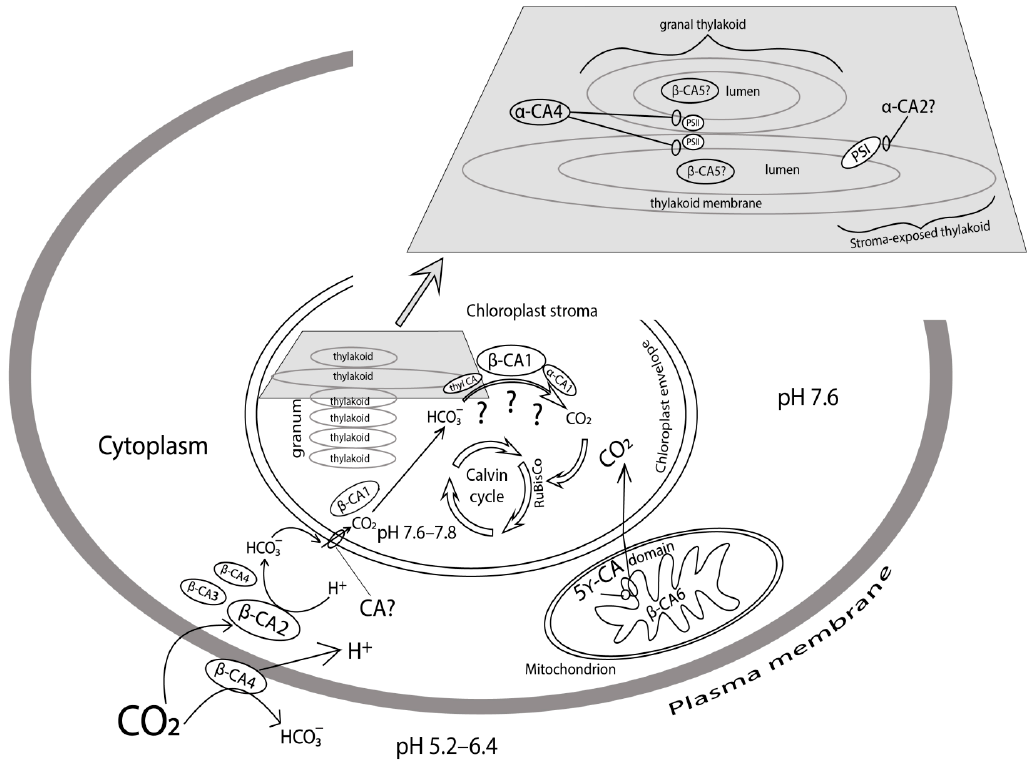
Figure 1. Schematic presentation of CA locations in the photosynthesizing cell of higher C3 plants.